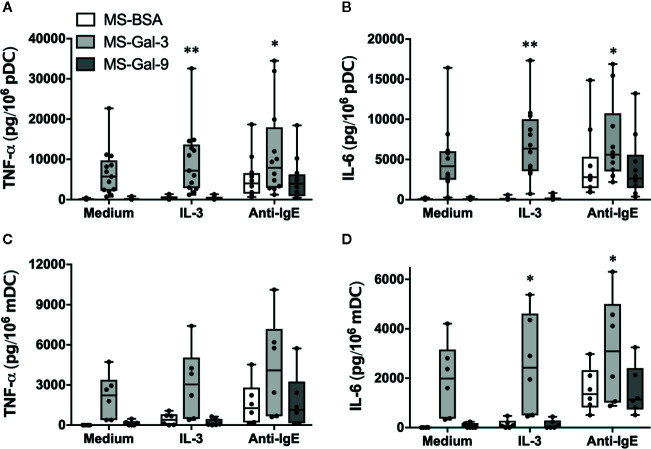
The effect of co-stimulation on Gal-3-dependent activation of dendritic cells (DCs). Human plasmacytoid DC (pDC) (A, B) and myeloid DC (mDC) (C, D) were co-cultured with MS-Gal-3, MS-BSA, or MS-Gal-9 as described above, but additionally in the presence of IL-3 (10 ng/ml), Anti-IgE (5μg/ml), or medium alone. Supernatants were harvested after 20 h and assayed for TNF-α and IL-6. Individual values (n=6-12) are shown within Box-Whisker plots. Co-stimulation with IL-3 and Anti-IgE were investigated for significance vs. using MS-Gal-3 alone. **P ≤ 0.008, *P < 0.05.